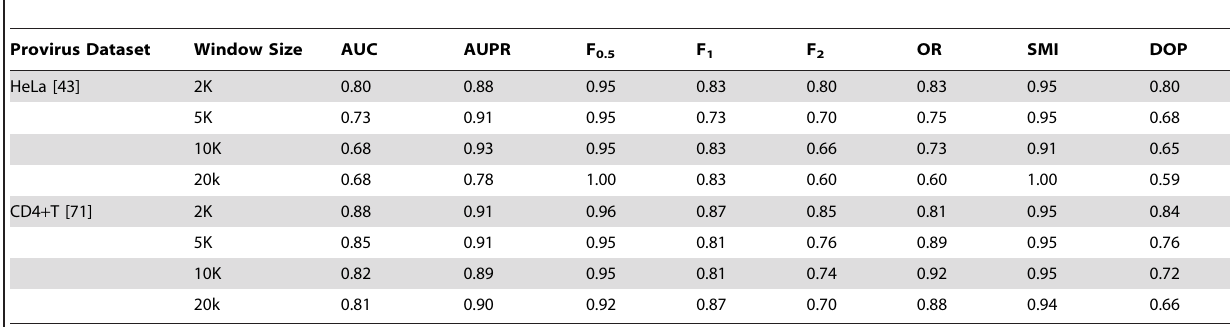
Table 4. Comparison of different methods for ranking markers of MLV integration.